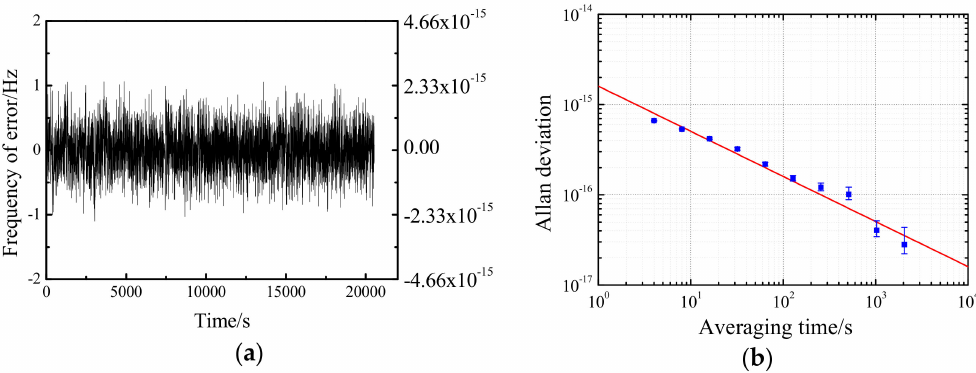
Figure 7. ( a ) Error signal after the clock laser locked to the atomic transition; ( b ) In-loop fractional frequency instability of the 87 Sr optical lattice